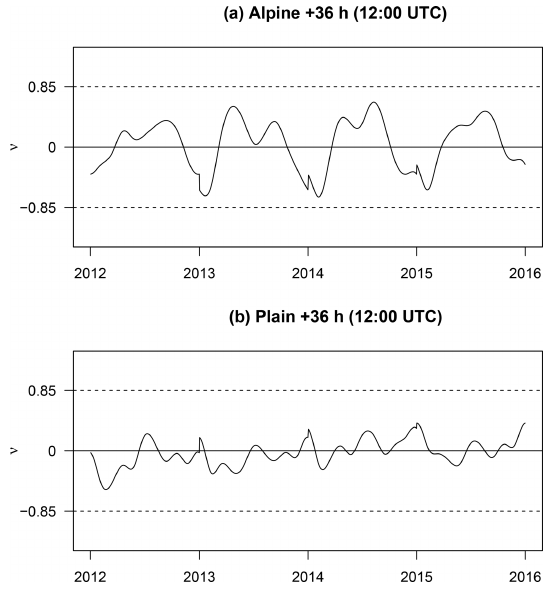
Figure 5. Joint time series of the empirical skewness ν of the fore- casted skewed logistic distribution for a lead time of + 36h for the Alpine station (a) and plain site (b) for all four cross-validation blocks. The years on the abscissa correspond to the left-out year of the cross-validation. Symmetric forecasts (no additional skew- ness required) would show a value of zero. The two dashed lines at ν = [− 0 . 85 , 0 . 85 ] are somewhat arbitrary and are shown to facili- tate orientation and to match the examples in Fig.